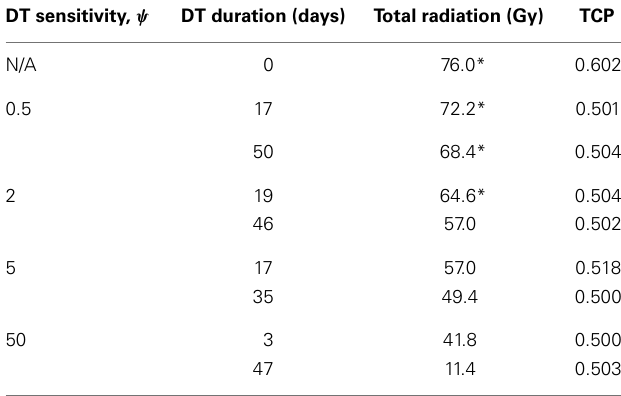
Table 3 |A selection of brain cancer treatment parameters resulting in TCP ≈ 0.5.